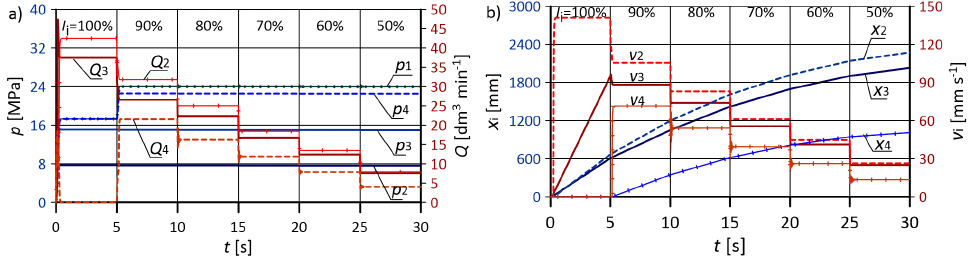
Figure 11. Results of the LSB system with variable load: F load ,2 = 37.5 kN, F load ,3 = 75 kN,